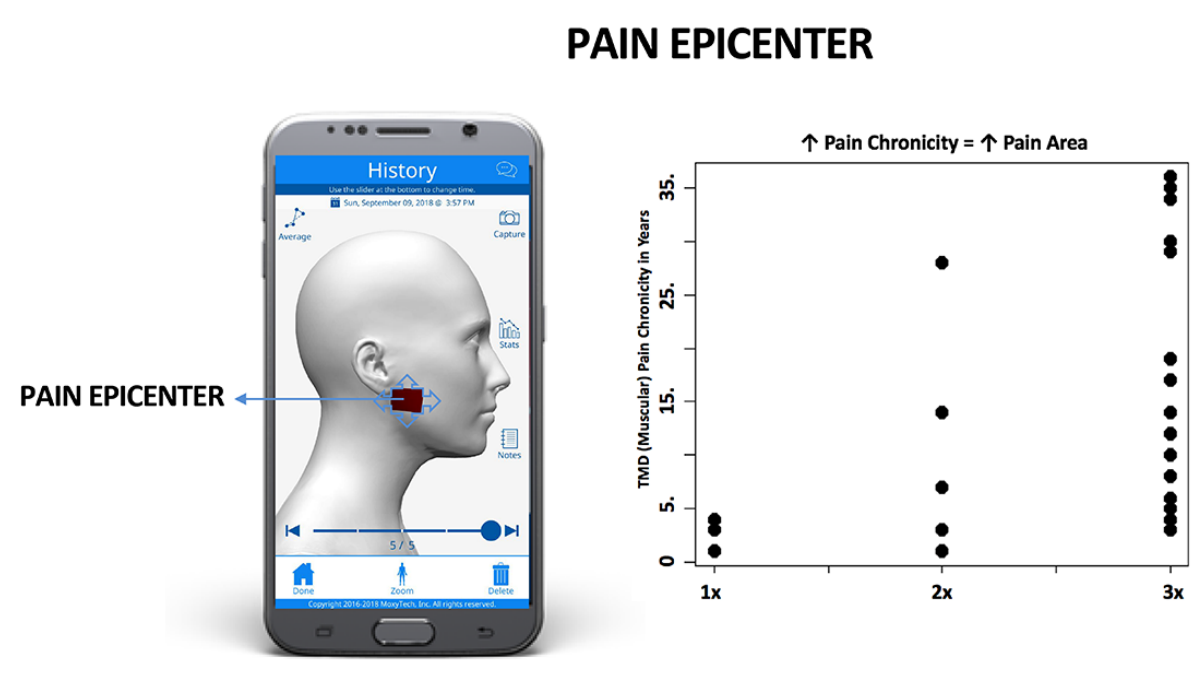
Figure 4. GeoPain measures demonstrated an association between chronicity and pain in locations farther away from the pain epicenter ( P =.01). Analysis using VAS detected neither an association at baseline for pain area nor chronicity. TMD: temporomandibular disorder; VAS: visual analog